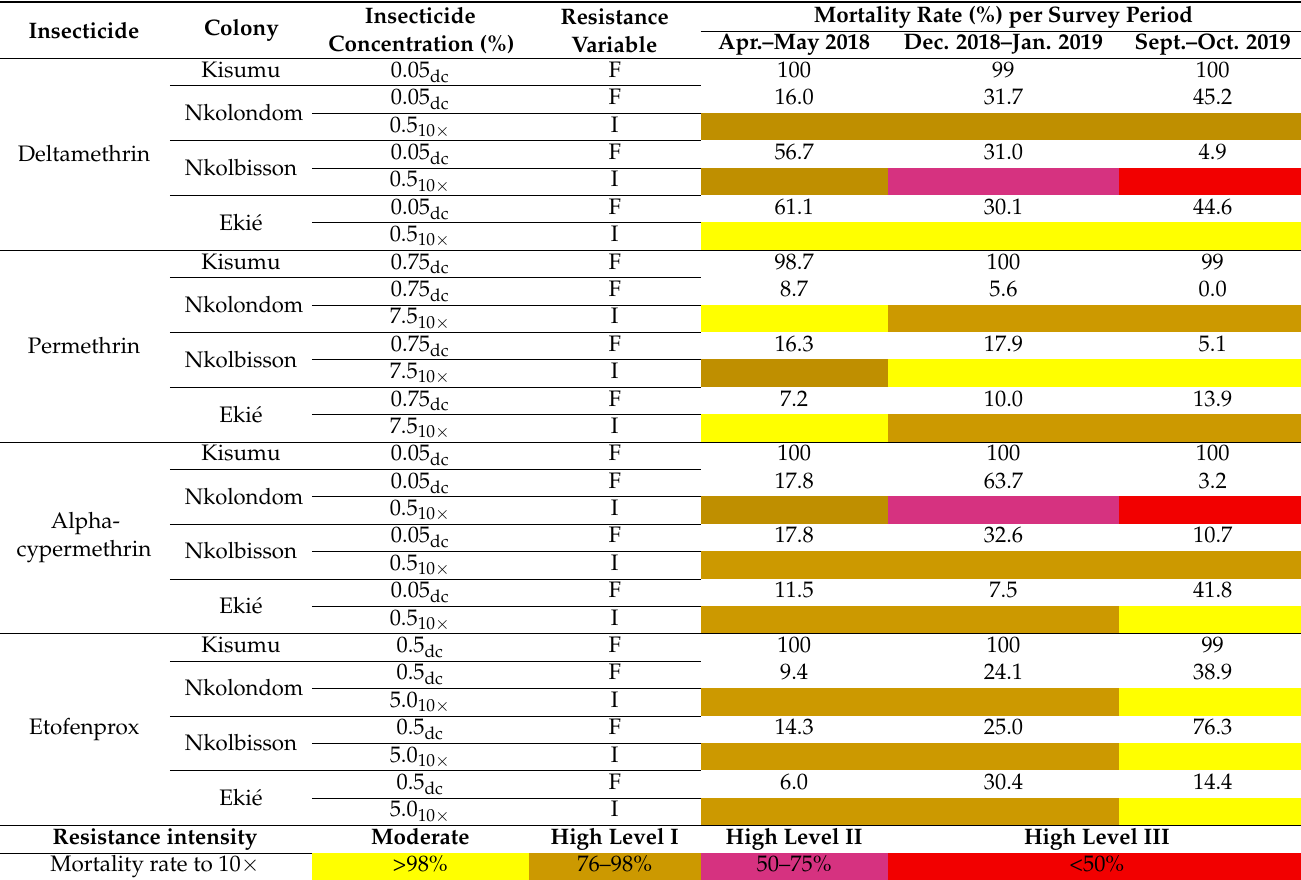
Table 2. Patterns of resistance frequency versus resistance intensity among Anopheles gambiae s.l. populations from Nkolondom, Nkolbisson and Eki é during the three